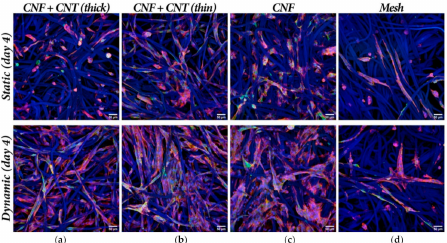
Figure A3. Porcine adipose tissue-derived stem cells (pASC) cultivated in a conventional static cell culture system for four days or in a pressure-generating dynamic cell culture system for three days (after one day of static cultivation). The cells were grown on a cellulose mesh with thick or thin CNF + MWCNT coating (column ( a ) and ( b ), respectively), with CNF coating (column ( c )), and without any coating (column ( d )). Cells were stained by immunofluorescence for vinculin (green), with TRITC-conjugated phalloidin for F-actin (red) and with DAPI for the nuclei (blue). Cellulose mesh had autofluorescence in the blue channel. Dragonfly 503 spinning disk confocal microscope with a Zyla 4.2 PLUS sCMOS camera, objective HC PL APO 20x / 0.75 IMM CORR CS2. Scale bar: 50 µ